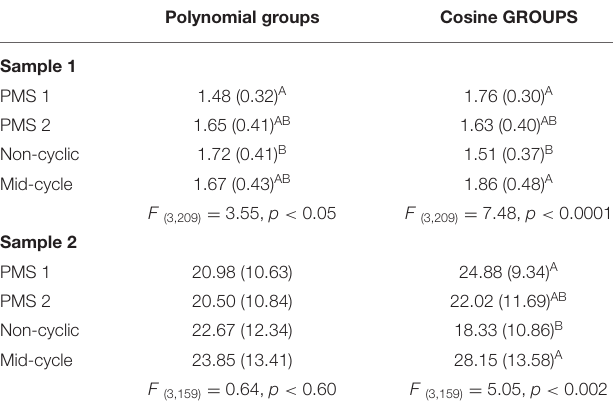
TABLE 4 | Mean levels/intercepts of depression/anxiety (SDs in parentheses), for diverse trajectory groups based on polynomial and cosine regressions, presented separately for two